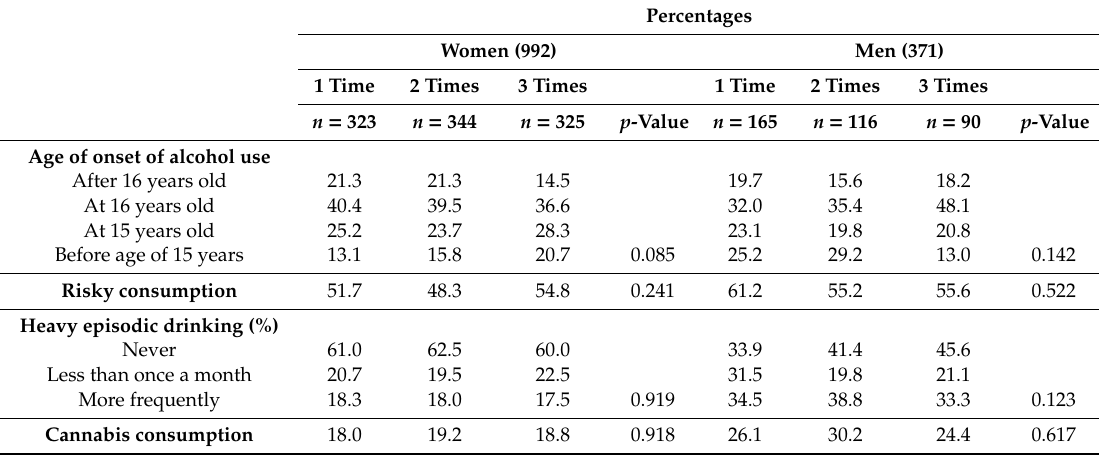
Table 1. Description of the samples at the beginning of the study according to the number of assessments carried out.